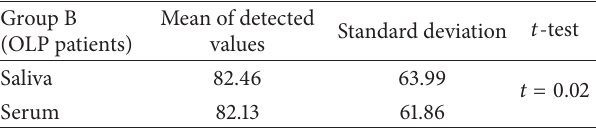
Table 6: Comparison of mean values of TNF- 𝛼 in saliva and serum of Group B. Group B Mean of detected (OLP patients) values Saliva 82.46 Serum